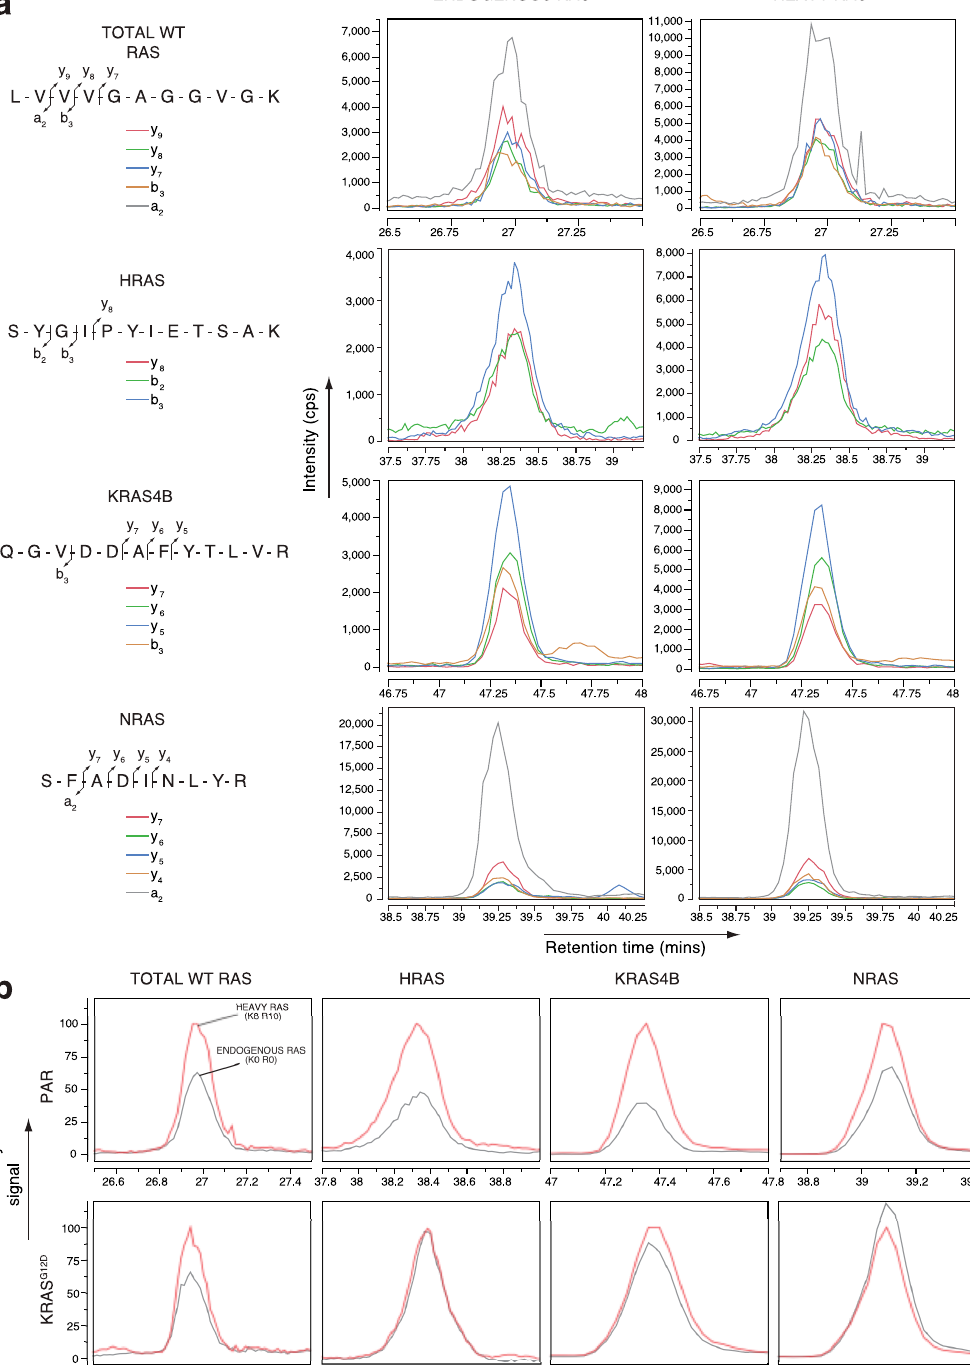
PLOS ONE | DOI:10.1371/journal.pone.0142674 November 11, 2015 8 /